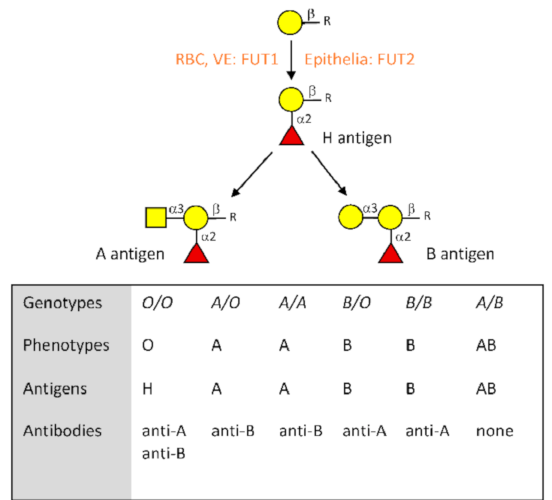
Figure 1. Description of the major characteristics of the ABO blood group system. Biosynthesis of the A and B antigens starts from a precursor structure constituted by a galactose residue in beta linkage to a subjacent sugar located at the termini of either N- or O-glycans as well as glycolipids. In red blood cells (RBC), vascular endothelial cells (VE) and other cell types such as megakaryocytes that give rise to platelets, addition of a fucose in α 1,2 linkage by the FUT1 enzyme gives rise to the H blood group antigen. In most epithelial cells, synthesis of the H antigen is performed by the FUT2 enzyme. Blood group A antigen is then synthesized by the A enzyme coded by A alleles of the ABO gene, while blood group B antigen is synthesized by the B enzyme coded by B alleles. O alleles are unable to generate a functional enzyme; therefore, O / O individuals leave the H antigen unchanged. Relationships between genotypes, phenotypes, antigens, and the corresponding natural antibodies are